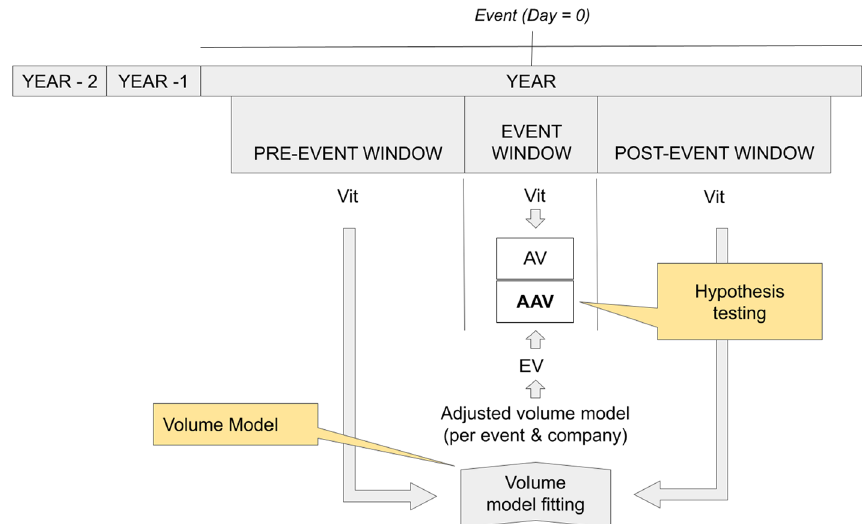
Fig. 11 Summary of the process of testing for significant average abnormal volumes. Source : Created by authors